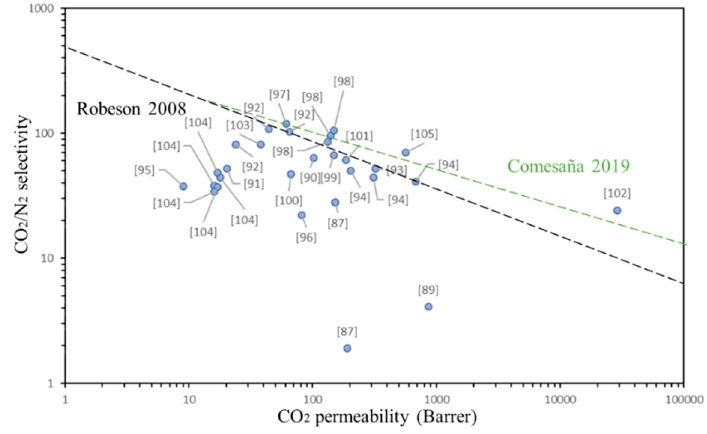
Figure 4. Upper bound correlation for CO 2 /N 2 separation.